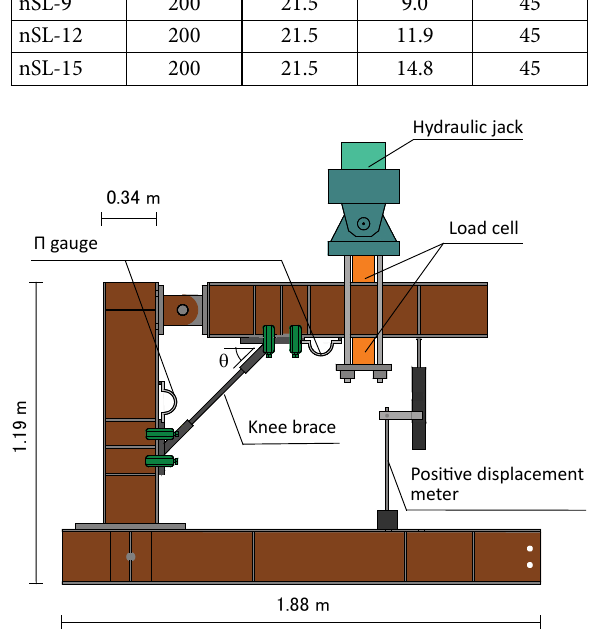
Figure 17. Loading and measuring devices